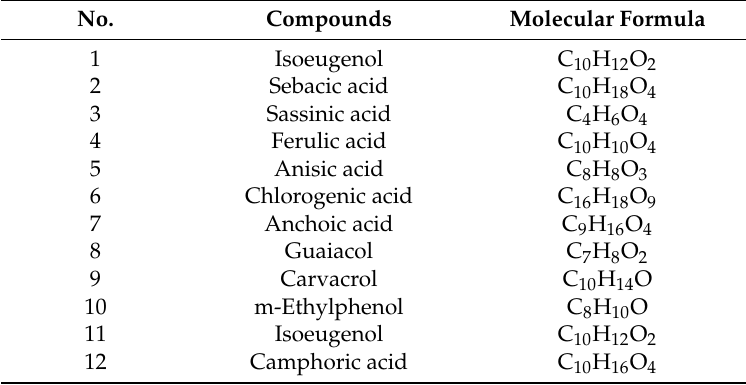
Table 1. The chemical composition of the organic acids of Angelica sinensis root extract.